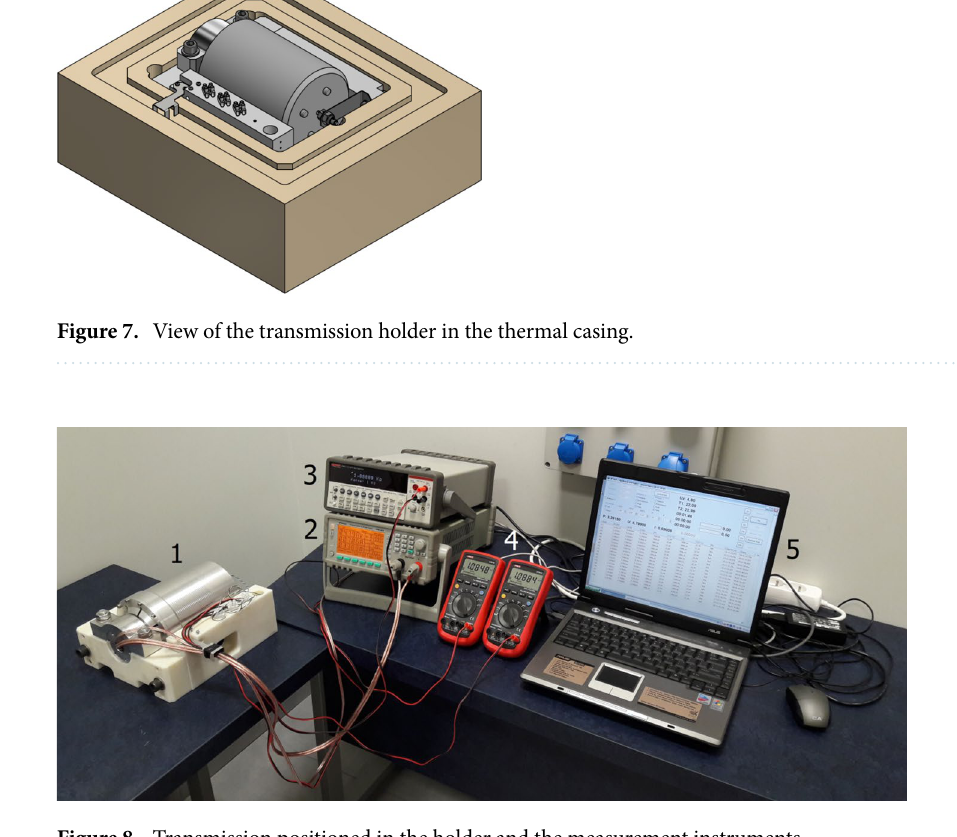
Figure 8. Transmission positioned in the holder and the measurement instruments.